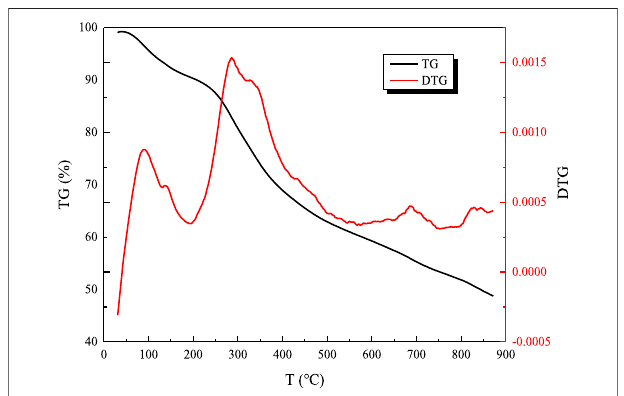
FIGURE 1 | TG-DTG curve of sewage sludge.